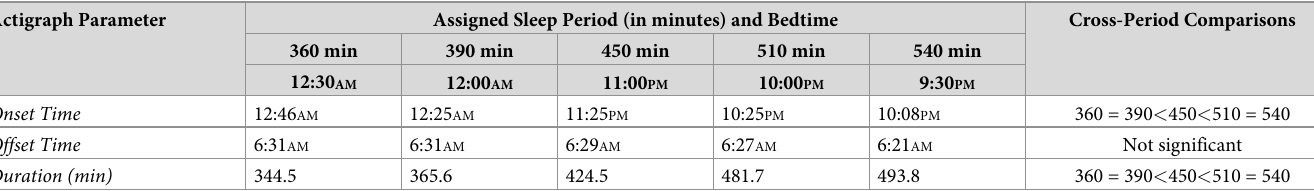
Table 4. Actual sleep onset, offset, and duration (as measured by actigraphy) across varying assigned sleep periods and bedtimes for adherent participants. Actigraph